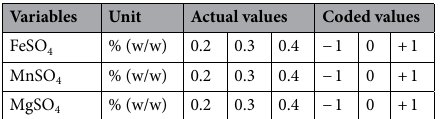
Table 2. Studied critical nutrients and their levels for Box-Behnken